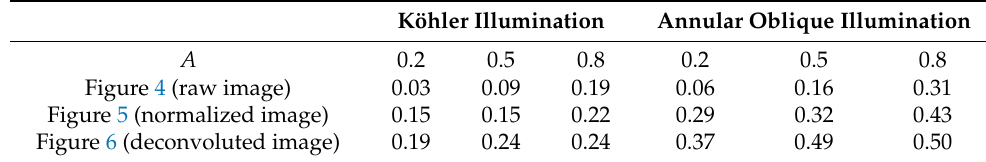
Table 1. The contrast of 201 to 300 pixels at the 170th column in simulated images. Köhler Illumination Annular Oblique Illumination